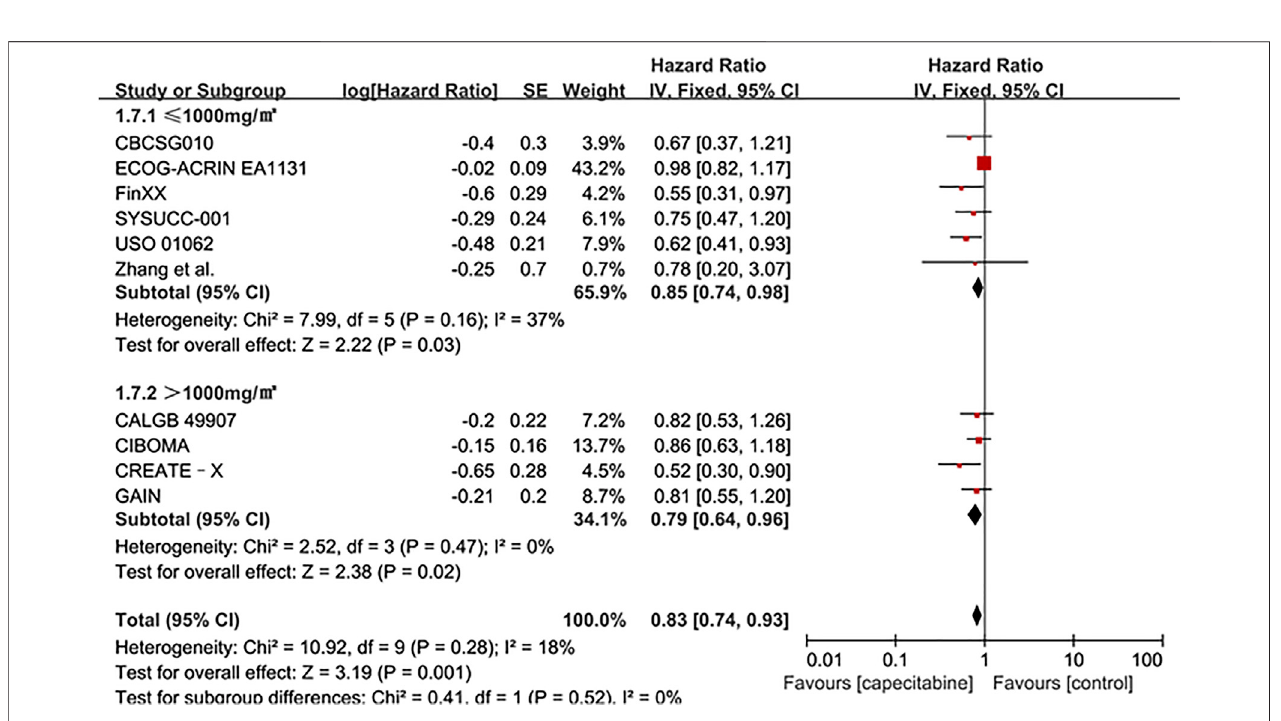
FIGURE 7 | Subgroup analysis of the effect of capecitabine adjuvant chemotherapy dose on OS in TNBC patients.